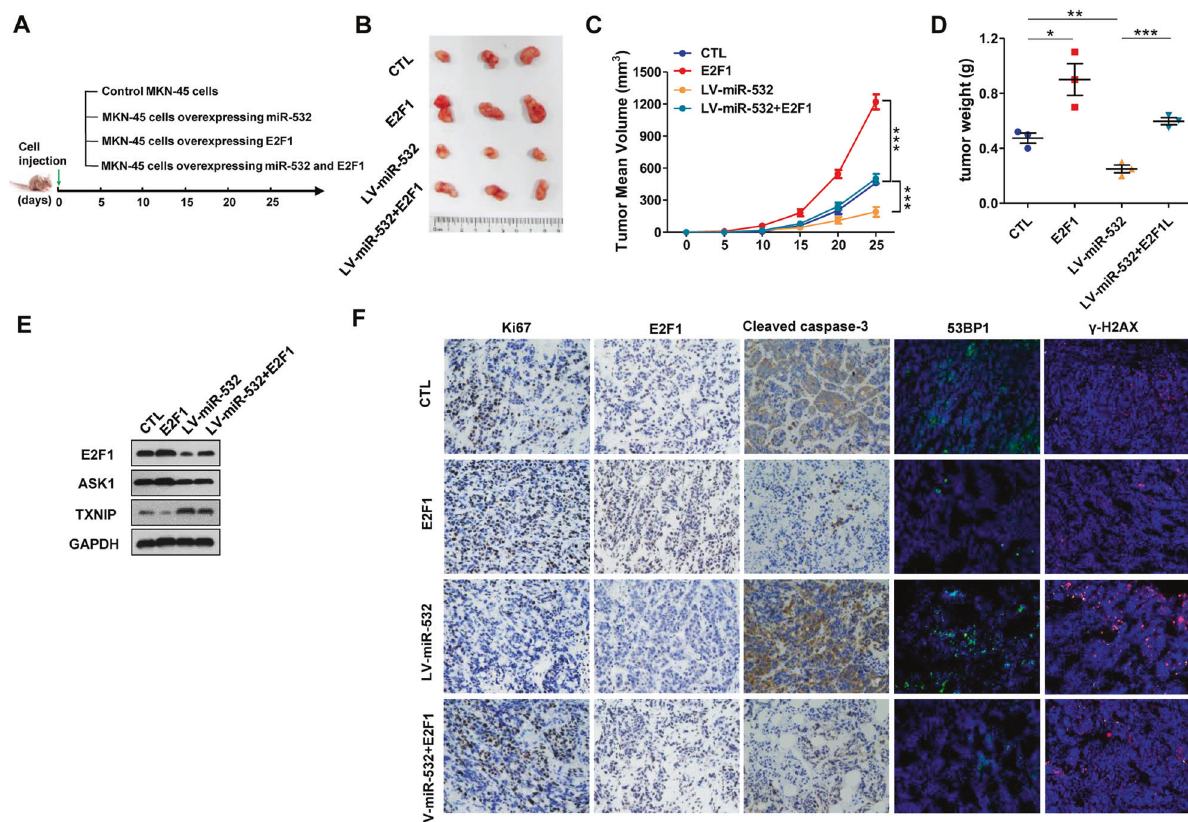
Fig. 7 The effect of E2F1-miR-532 loop on GC tumor growth in vivo. A A schematic diagram illustrating the experimental design. MKN-45 cells overexpressing miR-532, E2F1 or miR-532 plus E2F1 were implanted subcutaneously into nude mice (3 mice per group) and tumor growth was evaluated on day 25 after implantation. B Images of tumors from GC mice. C Tumor volume curves. D Tumour weights. E Western blot analysis of E2F1, ASK1 and TXNIP levels in GC xenografted tumors. F IHC staining for Ki-67, E2F1 and Cleaved caspase-3 and IF staining for 53BP1 and γ -H2AX in tumors from four groups. * P < 0.05; ** P < 0.01; *** P <